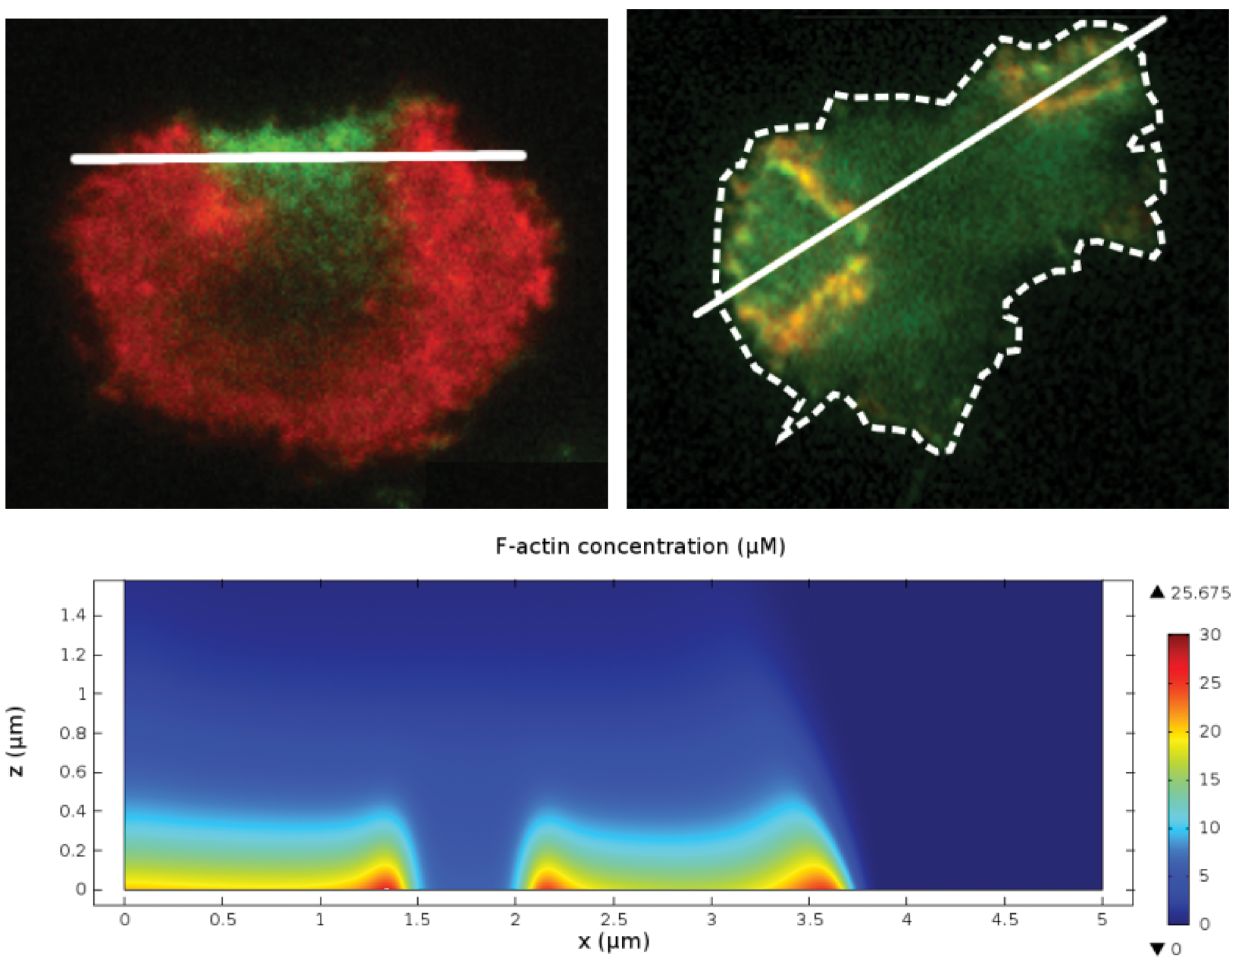
Figure 17. PTEN ingression and separated enclosed areas. (Upper left) PTEN ingression. PTEN (green) appears from the upper area of the cell- substrate contact, cutting through a portion of actin (red) wave front (adapted from [34]). (Upper right) Separated regions surrounded by actin waves. A TIRF image depicts F-actin (red) and Arp2/3 (green) density near the contact surface. A connected region is split into two regions after the wave front is broken at the bottom right of the cell (see [21]). New wave fronts are subsequently formed, connecting broken fronts with the existing wave front at the top left region and forming two separated regions. Dotted lines note the cell boundary. (Lower) A region enclosed by actin waves is divided and new wave fronts are formed by PTEN activity. New wave fronts are formed ~ 44 { 5 s after introduction of PTEN.